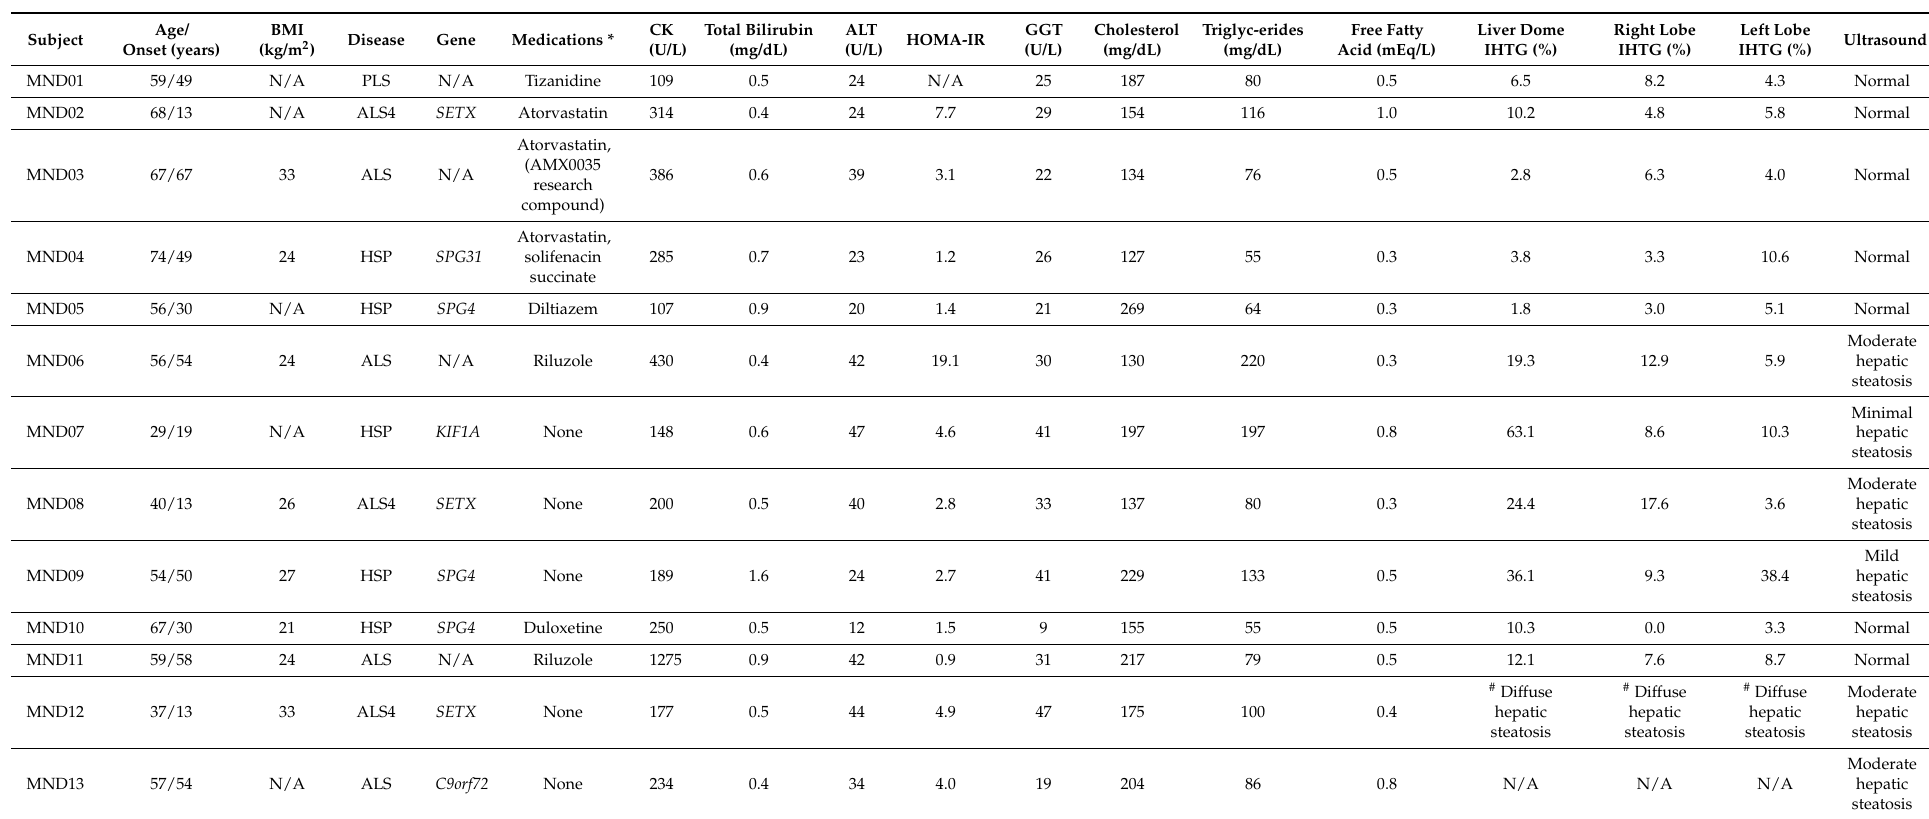
Table 1. Motor neuron disease cohort